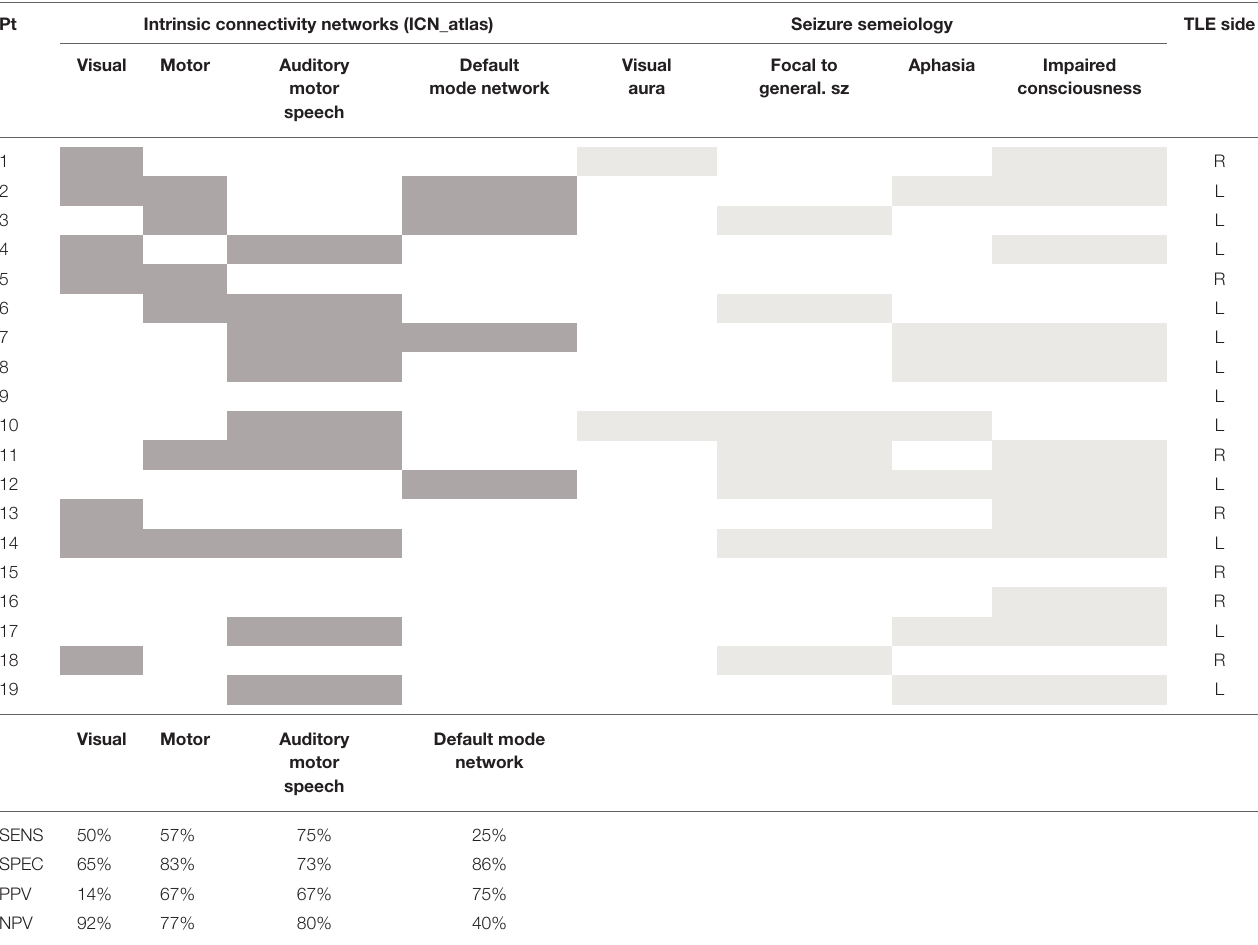
TABLE 3 | Concordance between Intrinsic Connectivity Networks (ICN) related to spike and seizure semeiology. Pt Intrinsic connectivity networks (ICN_atlas) Seizure semeiology TLE side Visual Motor Auditory motor